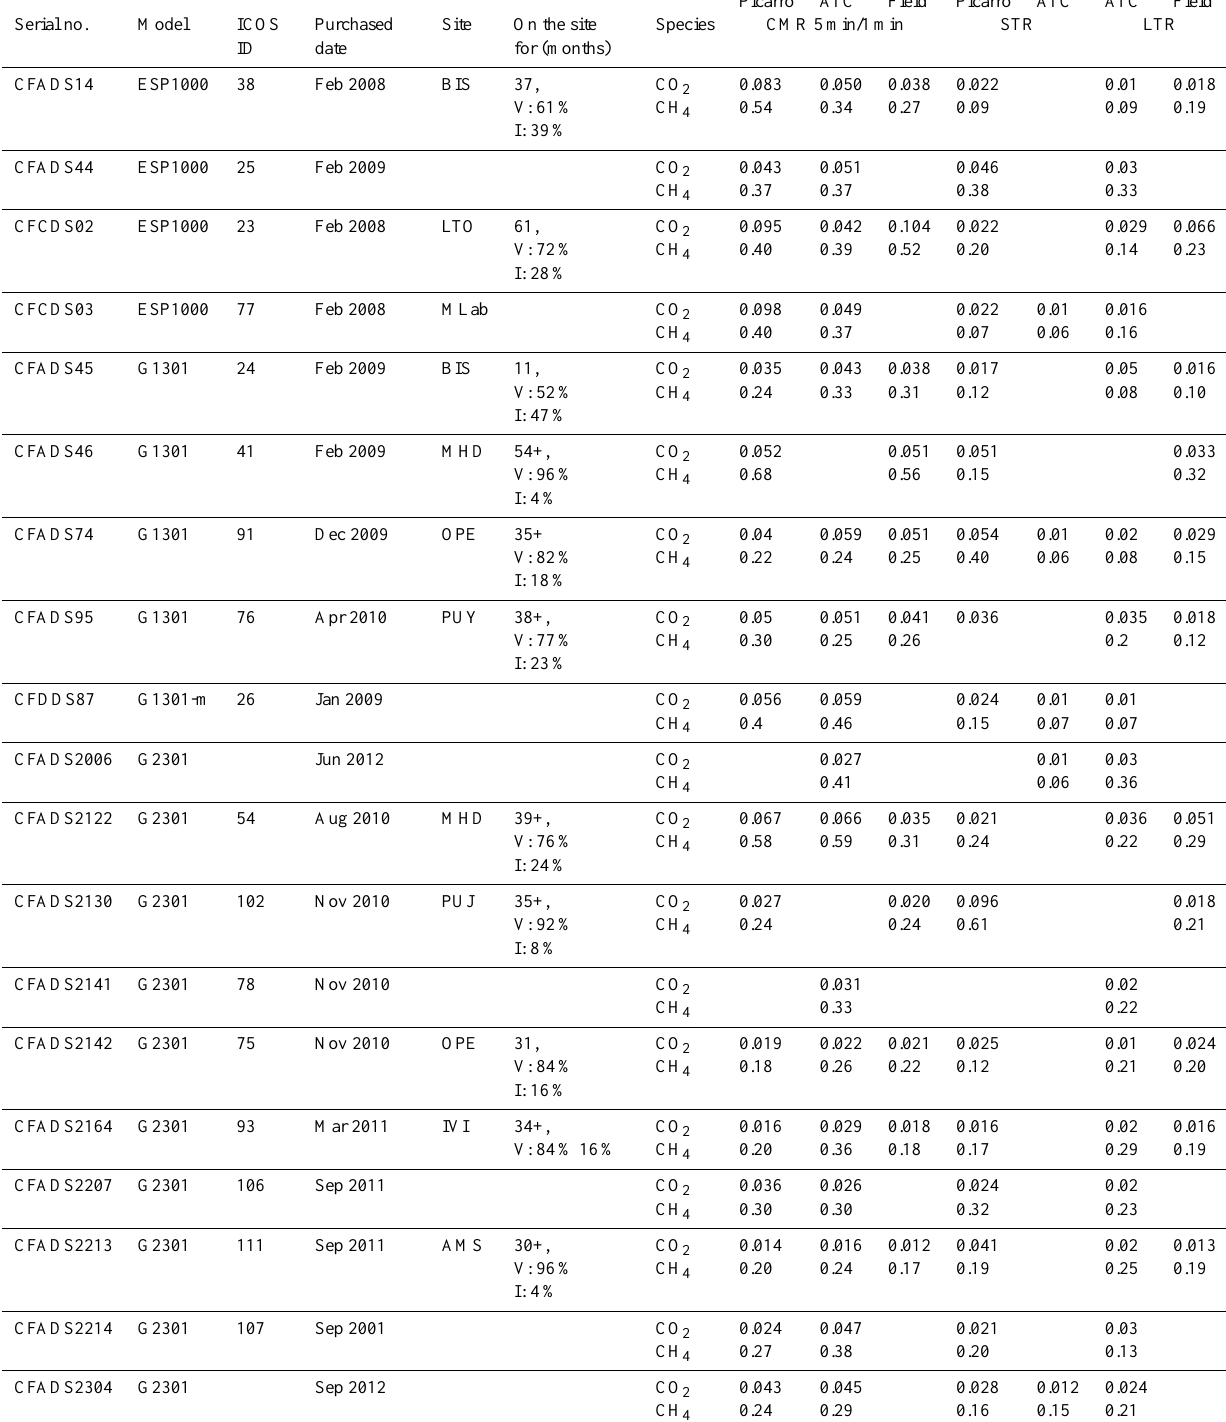
Table 1. The 47 analyzers considered in this study. Their serial number, model, ICOS number when attributed and period of purchase are indicated in the first columns. If field results are presented here, the site as well as the number of months the instrument was used in the span of this study ( + indicates that the instrument is still running) and the percentage of valid (V) and invalid (I) data are detailed. For the MLab site, these are the reference instruments used for comparison. Comparable results (continuous measurement repeatability (CMR), short-term repeatability (STR) and long-term repeatability (LTR)) between factory, MLab and field are shown for all